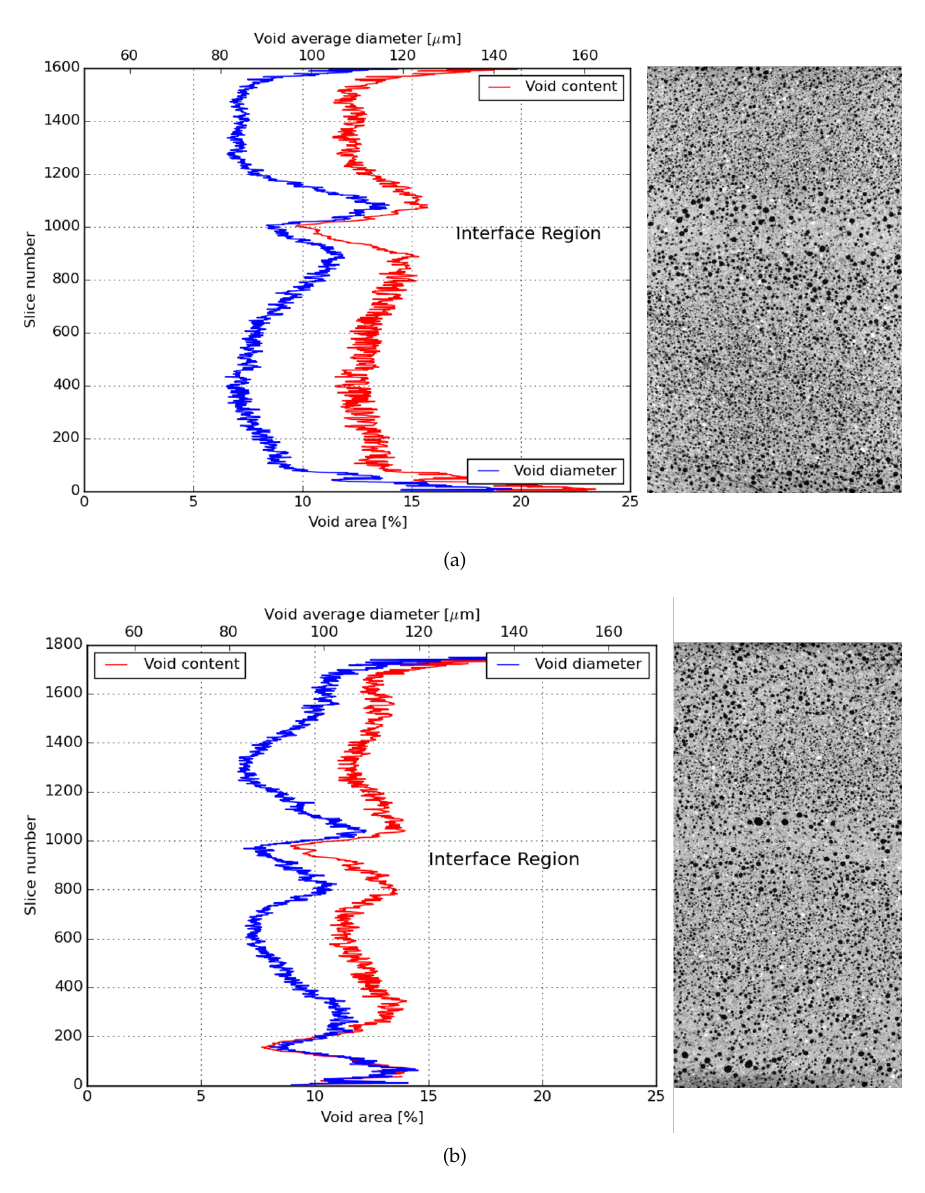
Figure 15. Average air void content and diameter distribution in the height of a 2-layer printed element of an X series. ( a ) X2T; ( b )